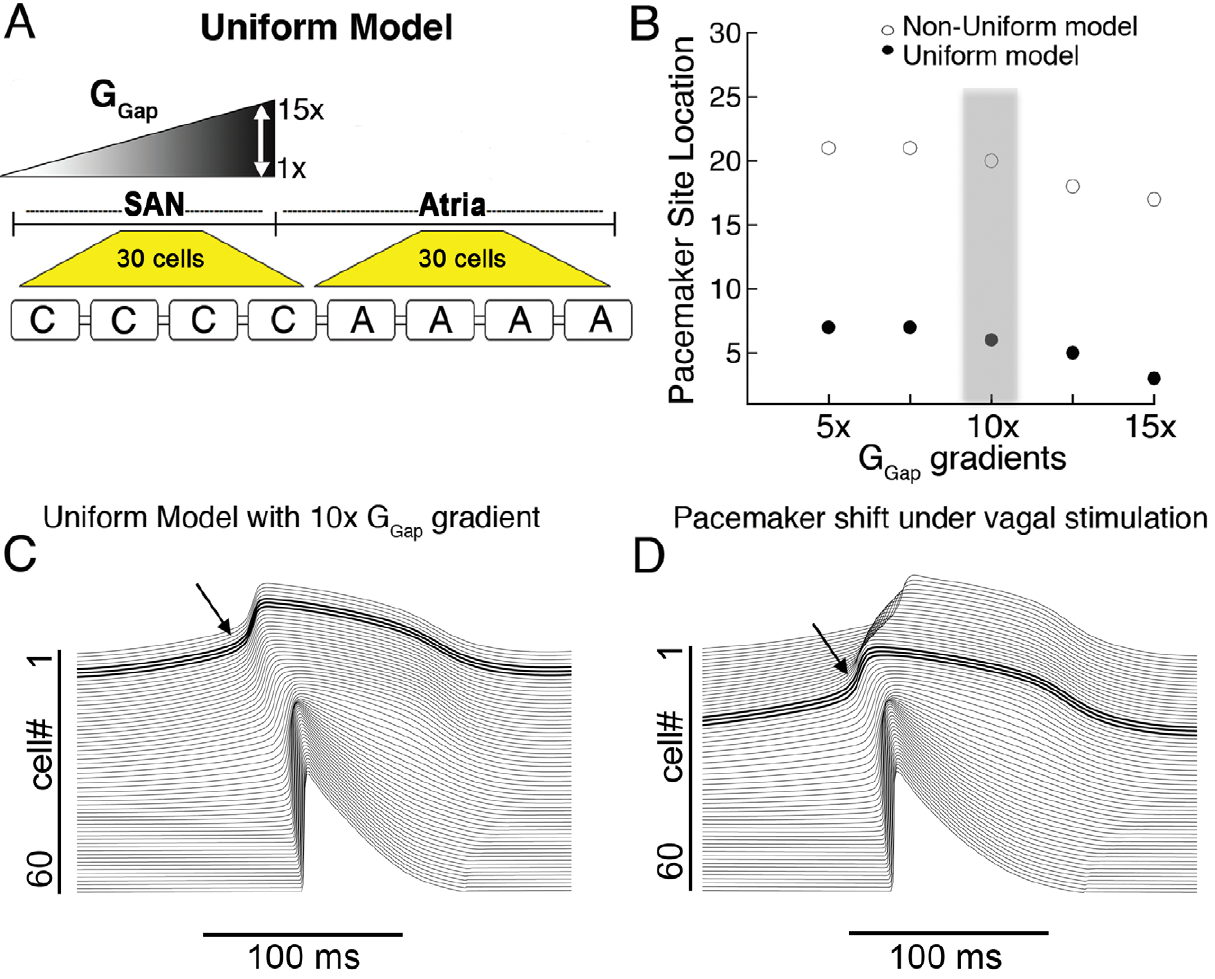
Figure 2. The uniform model. A) A schematic for the uniform model 1D strand is shown (‘C’ central cell, ‘A’ atrial cell and ‘G Gap ’ intercellular coupling). B) Within the physiologically observed range of intercellular coupling, only peripheral pacemaker initiation occurs in the non-uniform model (open circles), while the uniform model simulates central pacemaking for a range of physiological coupling values. C) A 10 6 gradient is shown to initiate pacemaking in the center. D) A simulated shift of the pacemaker site to the periphery due to vagal stimulation (from cell # 6 to cell # 21, bold traces).